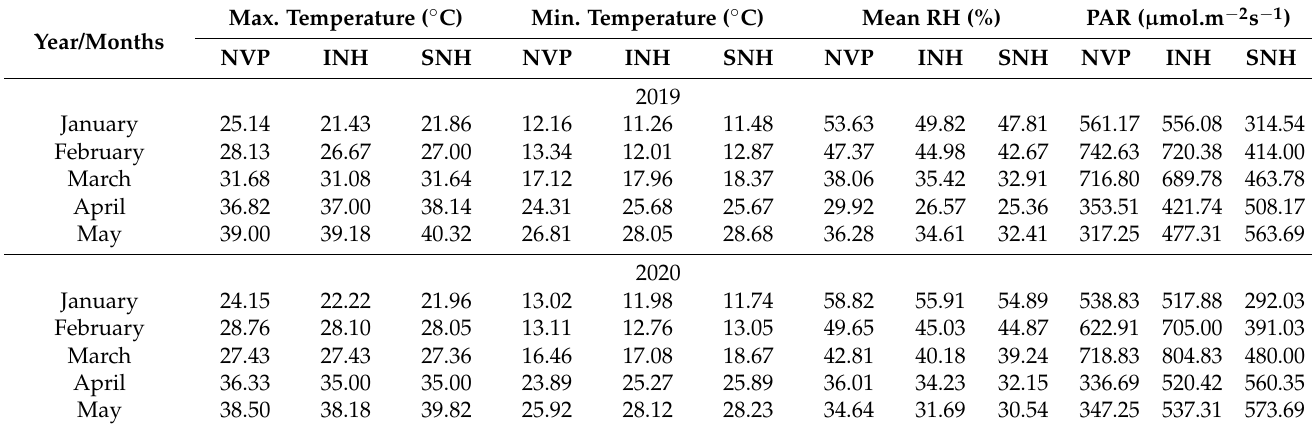
Table 1. Weather data (air temperature, relative humidity and PAR) of tomato growing